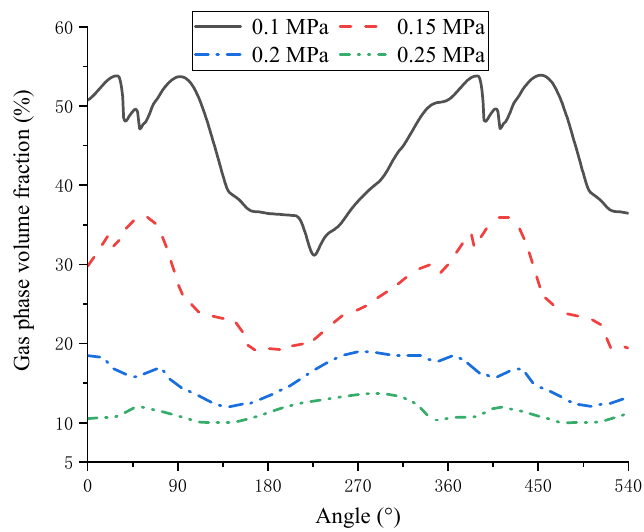
Figure 14. Gas ‐ phase volume fraction at different oil suction pressure.